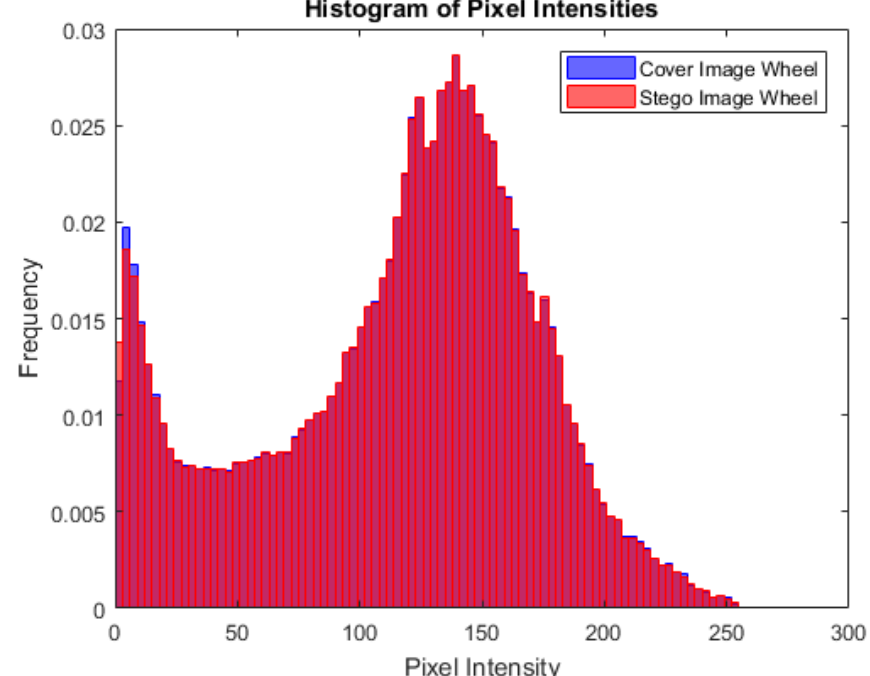
Figure 13. Histogram analysis plots of Wheel for the proposed technique.